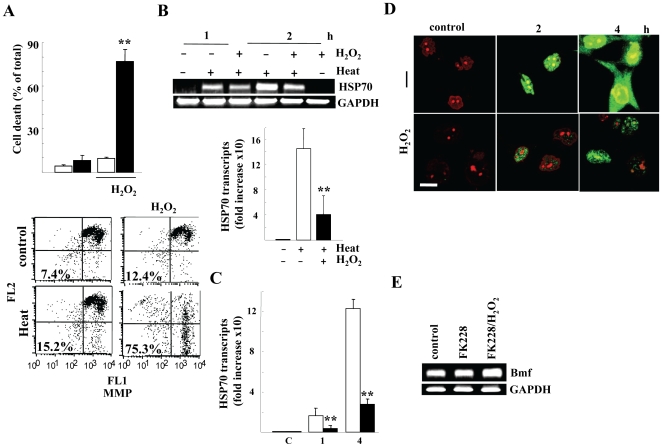
Effect of H2O2 on heat-exposed A172 cells.
A) Cell death at 24 h (upper) and disruption of Δψm (lower panel) at 20 h after heat (44°c for 20 min) exposure (closed bars) with or without 0.25 mM H2O2. Numbers indicate % of cells showing loss of Δψm. B) HSP70 transcripts. Total RNA was harvested from cells treated with the indicated and transcripts of the indicated genes were evaluated by RT-PCR (upper). HSP70 transcripts were determined by real-time PCR and normalized to GAPDH levels (lower panel). C) Time-course of HSP70 transcripts. At the indicated hours after heat exposure with (closed) or without (open bars) 0.25 mM H2O2, HSP70 transcripts were determined by real-time PCR and normalized to GAPDH levels In A-C, error bars indicate the mean ± S.D. of data from three separate experiments and **, P<0.01 compared with H2O2-untreated cells. D) Confocal microscopical detection of HSP70. Cells were pretreated with (H2O2) or without (control) 0.25 mM H2O2 and fixed at the indicated hours after heat (44°c for 20 min) exposure. HSP70 expression was immunohistochemically detected using the anti-HSP70 antibody counter-stained with PI. Bar indicates 10 µm. E) Bmf transcripts evaluated by RT-PCR of total RNA harvested at 6 h after treatment with the indicated agents for 6 h In B and E, GAPDH mRNA levels ensure that the RNA was correctly quantified.